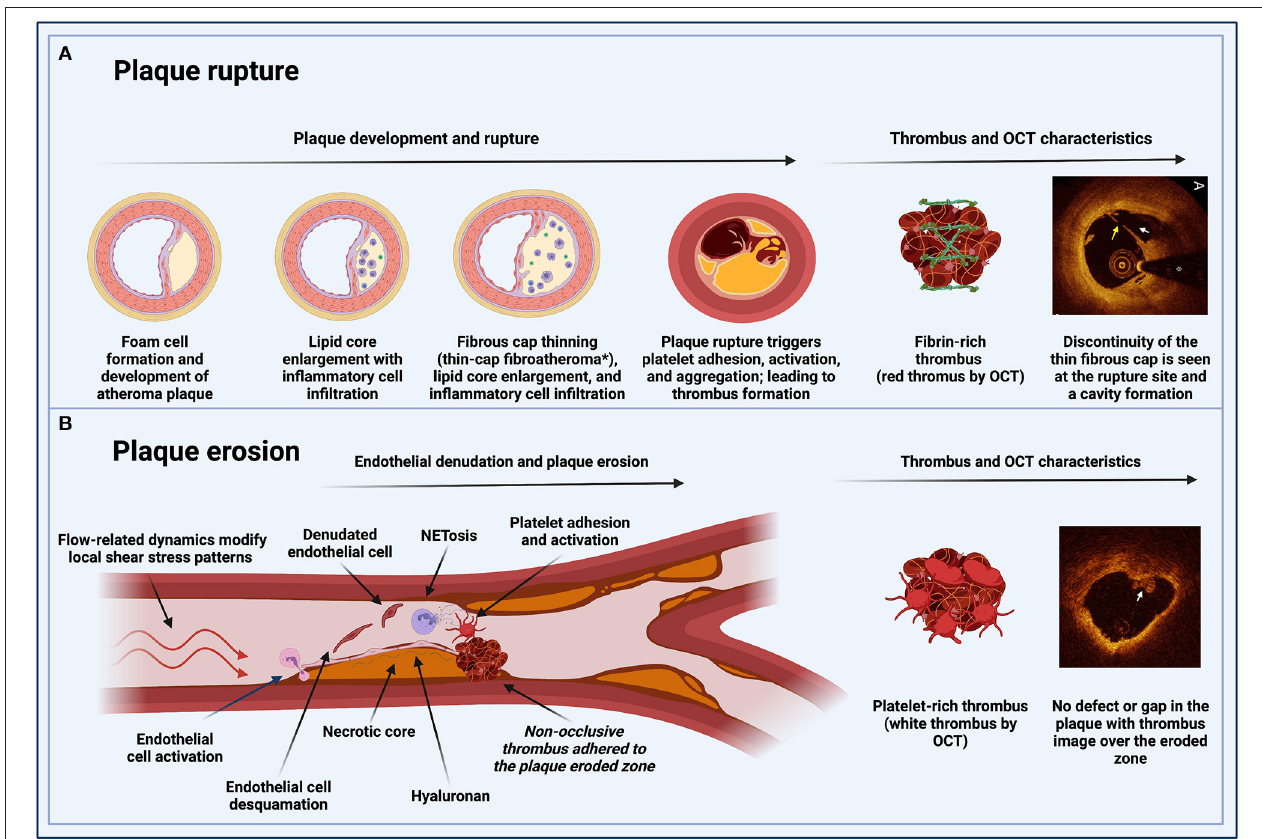
FIGURE 1 | Pathophysiological pathways of MINOCA in patients with atherosclerotic disease. (A) Plaque rupture: inflammation is involved in the process of plaque development and rupture. Unstable plaques have a large lipid core and a thin fibrous cap with reduced collagen content. A major component of plaque destabilization appears to be increased matrix degradation, the primary regulators of which are the matrix metalloproteinase. Plaque rupture occurs where the cap is thinnest and most infiltrated by foam cells. In eccentric plaques, the weakest spot is often the cap margin or shoulder region, and only extremely thin fibrous caps are at risk of rupturing. Exposure of the thrombogenic lipid core material lead to fibrin-rich thrombus formation. (B) Plaque erosion: flow-related dynamics modify local shear stress patterns on the endothelial monolayer. The basement membrane (endothelial-to-mesenchymal transition) is degraded. These changes result in the desquamation of the endothelial cells from the basement membrane and their subsequent death by apoptosis. Neutrophils in the area undergo a particular type of apoptosis (NETosis) to form neutrophil extracellular traps (NETs), which produce a potent inflammatory stimulus containing tissue factor, leading to entrapment of circulating platelets